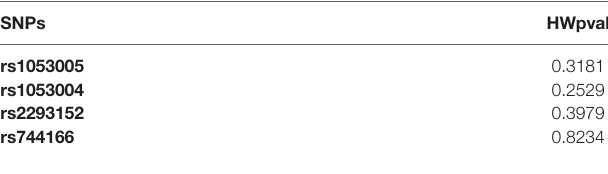
TABLE 2 | Hardy – Weinberg equilibrium analysis.